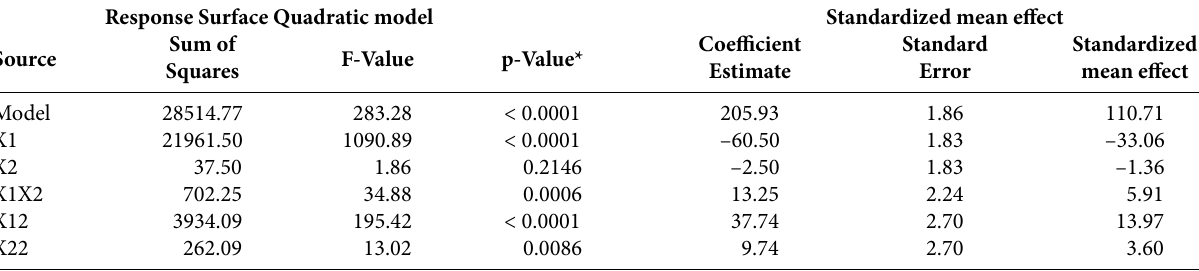
Table 5. Analysis of variance